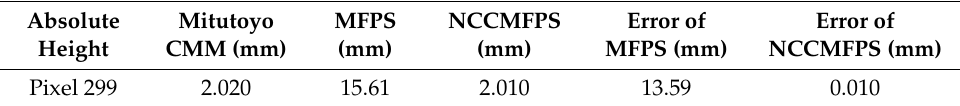
Figure 12. Measurement results for the 2-mm step-height target in Figure 11: ( a ) 3D profile; ( b ) height cross-sections on column 256 for both MFPS (red) and NCCMFPS (blue). Table 1. Results for step-height target measured using di ff erent